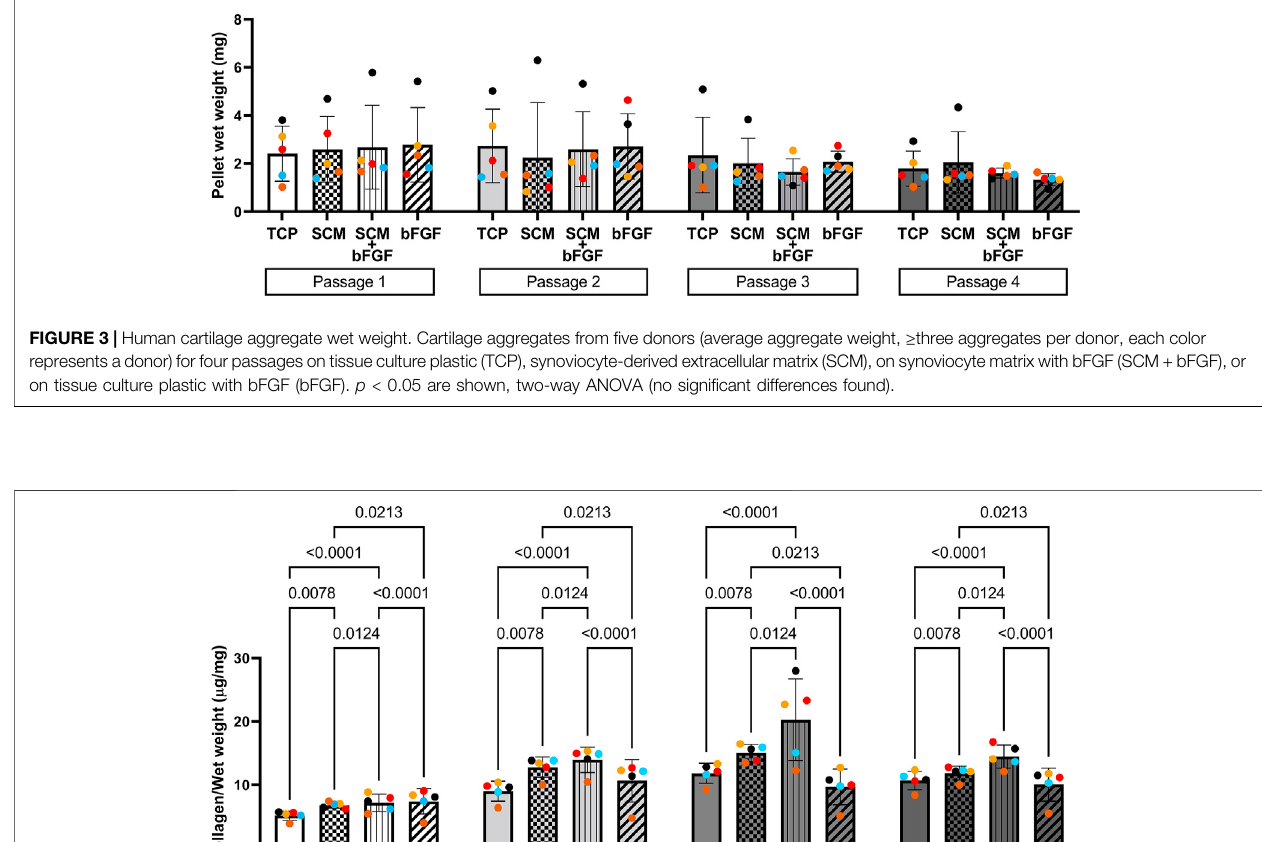
Frontiers in Bioengineering and Biotechnology |